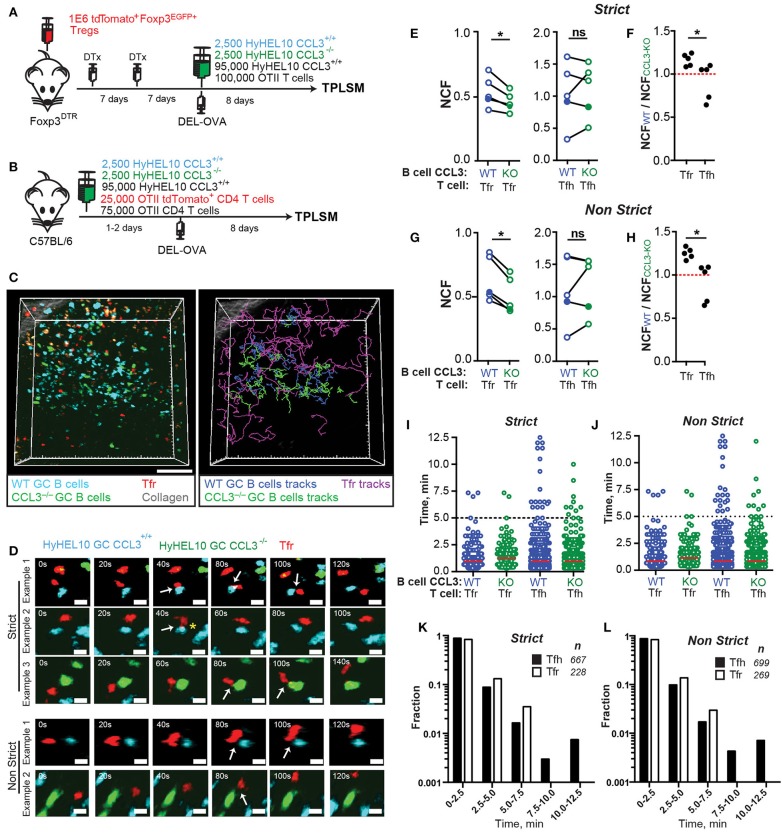
Tfr cells make less frequent contacts with CCL3-KO B cells in GCs. 2P imaging analysis of Tfr and Tfh cells contacts with CCL3+/+ CFP and CCL3−/− GFP HyHEL10 GC B cells in the dLNs of mice at 8 d.p.i. (A,B) Experimental diagrams for imaging GC B cell interactions with Tfr (A) and Tfh (B). (C) snapshot (left panel) and cell trajectory analysis (right panel) from an intravital imaging experiment performed as described in (A). Scale bars: 50 μm. Auto-fluorescent cells are orange. (D) Time-lapse images of Tfr cells interacting with CCL3+/+ or CCL3−/− HyHEL10 B cells within GCs. Cell contacts were verified in 3D space, classified as Strict (definitive contacts) and Non-Strict (all possible contacts) and indicated by white arrows. Yellow star illustrates pseudopod extension by a Tfr cell toward CFP GC B cell. Images are displayed as 20 μm z-stacks. Scale bars: 5 μm. (E–J) Quantitative analysis of CCL3+/+ (blue circles) and CCL3−/− (green circles) HyHEL10 GC B cell interactions with Tfr or Tfh cells. Closed symbols represent intravital and opened symbols—explanted dLNs imaging. The data was analyzed in a blinded fashion to avoid possible bias in cell contact definition. (E,G) Normalized contact frequency (NCF) calculated for Strict (E) and Non-Strict (G) contacts as the number of Tfr or Tfh cells' interactions with CCL3+/+ and CCL3−/− HyHEL10 B cells within defined volume of GCs normalized to the average number of HyHEL10 cells of each genotype. Linked symbols correspond to GC B cells in the same movie. *P < 0.05, Wilcoxon matched-pairs test. (F,H) Ratios of the Tfr or Tfh cell NCF with CCL3+/+ over CCL3−/− HyHEL10 B cells from the same movie. *P < 0.05, Student's t-test. (I,J) Contact duration between Tfr or Tfh and HyHEL10 GC B cells of each genotype undergoing Strict (I) or Non-Strict (J) interactions. Red lines represent medians. Data from five independent experiments (5 mice) per T cell type. (K,L) Time histograms for duration of strict (K) and non-strict (L) contacts between Tfr and Tfh cells with WT HyHEL10 GC B cells.